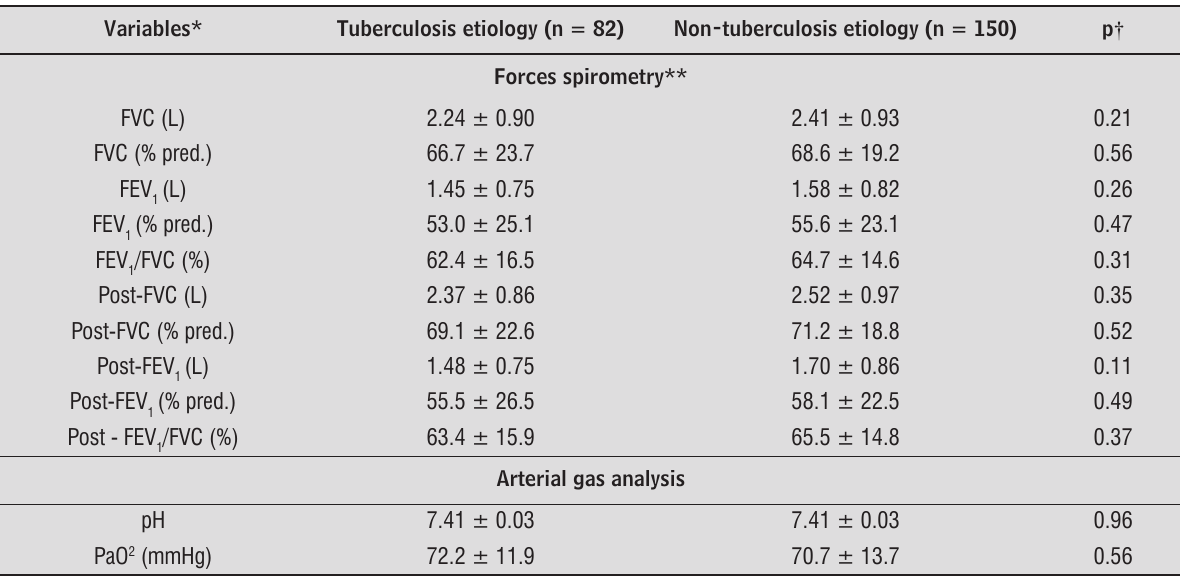
Table 5 – Forced spirometry and blood gases analysis in patients with non-cystic fibrosis bronchiectasis according to etiology (tubercu- losis versus non-tuberculosis)